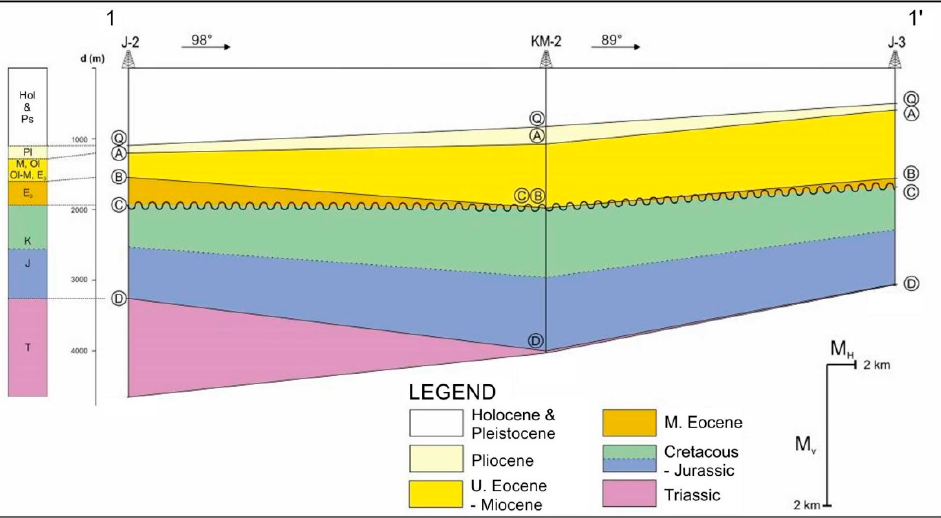
Figure 5. Schematic correlation of section 1–1 ′ (location in Figures 3 and 4).